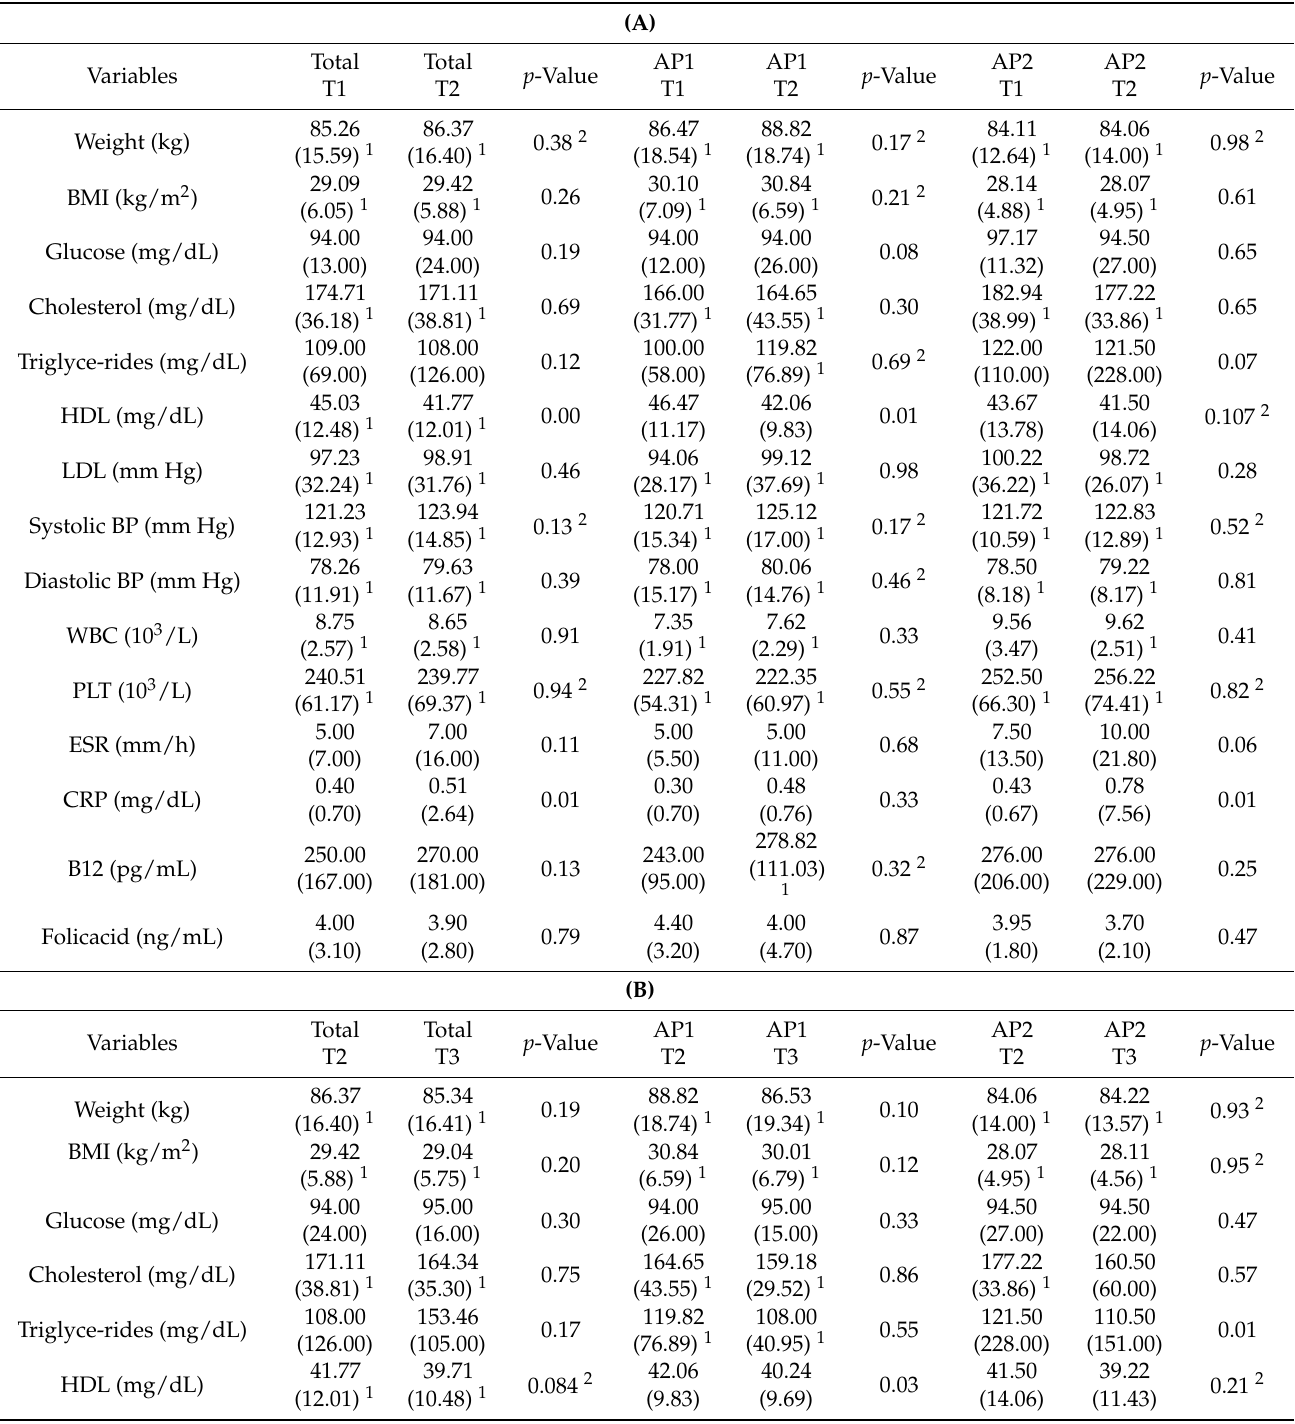
Table 2. ( A ). In-group difference tests on the overall sample and the subgroups of forensic psychiatric patients receiving antipsychotic medication (AP1 and AP2) in the years 2018 (T1) and 2019 (T2). ( B ). In-group difference tests on the overall sample and the subgroups of forensic psychiatric patients receiving antipsychotic medication (AP1 and AP2) in the years 2019 (T2) and 2020 (T3). ( C ). In-group difference tests on the overall sample and the subgroups of forensic psychiatric patients receiving antipsychotic medication (AP1 and AP2) in the years 2018 (T1) and 2020